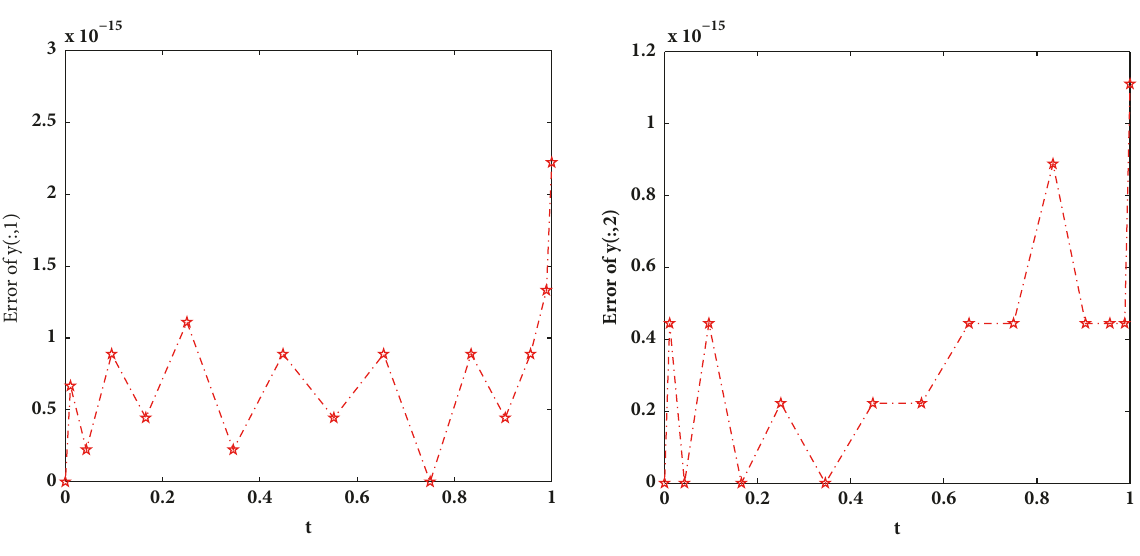
Figure 2: Errors of 𝑦 1 and 𝑦 2 for Example 2 when 𝑁 = 16 .